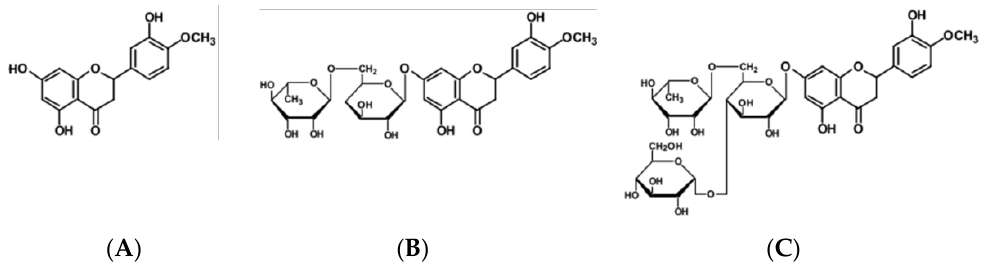
Figure 1. Structures of hesperidin and related compounds. ( A ) hesperetin, ( B ) hesperidin and ( C ) hesperidin glucoside (mono-glucoside).